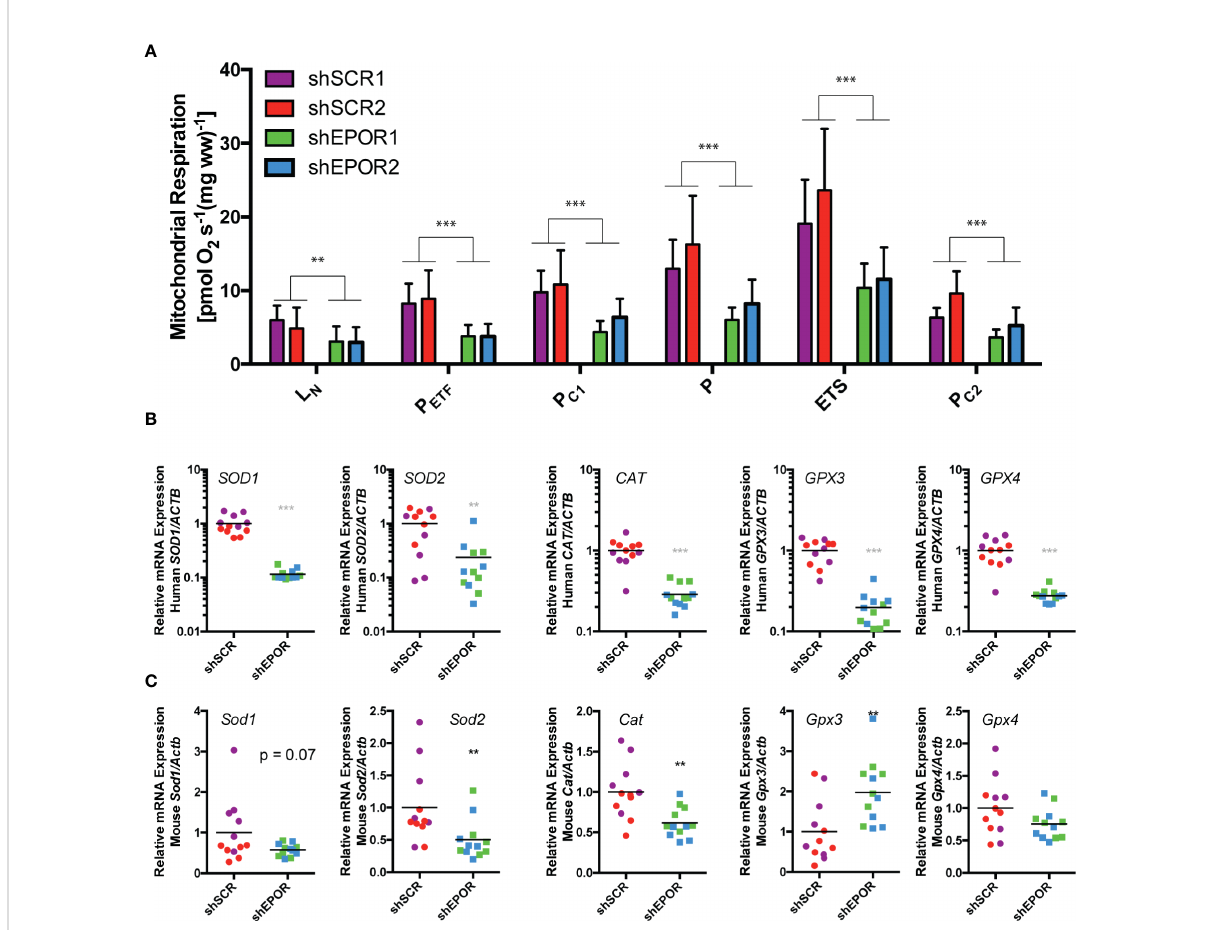
FIGURE 2 Knockdown of EPOR reduces cellular respiration of human A549 lung cancer xenografts in Foxn1nu mice. Biopsies of human A549 tumors that either express EPOR (shSCR1/2) or not (shEPOR1/2) were isolated from Foxn1nu mice and mass-speci fi c respiration was immediately measured by high-resolution respirometry. Panel (A) shows the mass-speci fi c respiration per unit weight of freshly isolated tumor biopsies of shSCR and shEPOR A549 tumors (n=6-7). L N , respiration in the absence of adenylates; P ETF , capacity for fatty acid b -oxidation; P C1 , submaximal state 3 respiration through complex I; P, maximal state 3 respiration - oxidative phosphorylation capacity; ETS, electron transport system capacity; P C2 , submaximal state 3 respiration through complex II. Relative mRNA expression of human and murine genes was analyzed by qPCR in A549 tumors: Shown are (B) mRNA levels of human superoxide dismutase 1 ( SOD1 ), human superoxide dismutase 2 ( SOD2 ), human catalase ( CAT ), human glutathione peroxidase 3 ( GPX3 ) and human glutathione peroxidase 4 ( GPX4 ) normalized to human b-Actin ( ACTB ) mRNA levels as well as (C) mRNA levels of murine superoxide dismutase 1 ( Sod1 ), murine superoxide dismutase 2 ( Sod2 ), murine catalase ( Cat ), murine glutathione peroxidase 3 ( Gpx3 ) and (murine glutathione peroxidase 4 ( Gpx4 ) normalized to murine b-Actin ( Actb ) mRNA levels of shSCR and shEPOR A549 tumors (n=16). Data are shown as means and standard deviations (A) or as scattered blots with mean and individual data distribution ( B, C ) of each control or EPOR-knockdown clone (control: shSCR1 purple, shSCR2 red; EPO- knockdown: shEPOR1 green and shEPOR2 blue tumor samples). The graphs in panel (B) are on a logarithmic scale. Data were analyzed by a Student ’ s t-test (black stars) or by a Mann-Whitney test (grey stars). ***p<0.001;